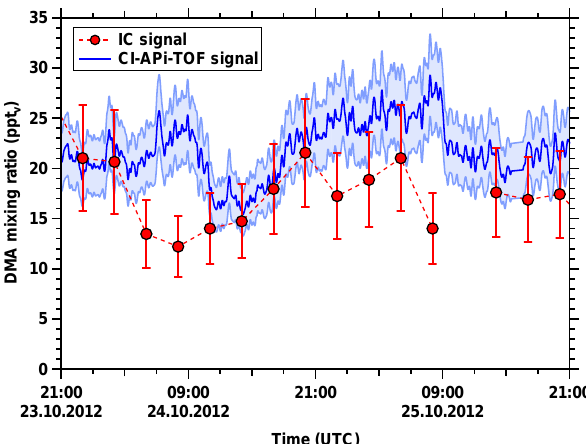
Figure 6. Comparison between the measured ion chromatograph (IC) signal and the calculated CI-APi-TOF signal in pptv. The CI- APi-TOF signal is determined by the raw ion counts multiplied by the calibration factor C , which is defined by the slope of the linear fit for CLOUD7 (red line of Fig. 4). Both signals show in general a reasonable agreement but the IC signal is lower on average and point-to-point variability is large. The uncertainty (shown as error bars) of the IC instrument ( ± 25%) is based on the calibration. The 14% uncertainty of the CI-APi-TOF is shown as light blue shaded area. The mean values over the entire time period displayed are 17 ± 3pptv for the IC and 22 ± 3pptv for the